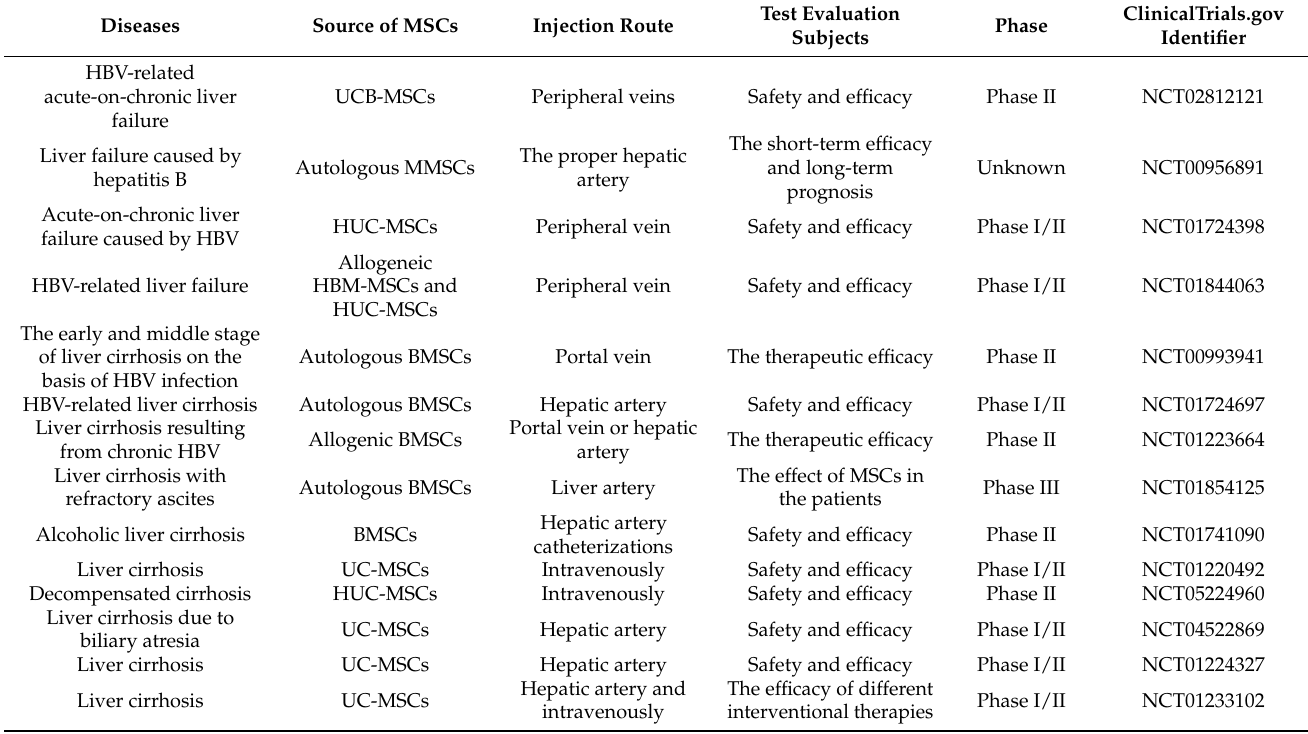
Table 1. Part of clinical studies related to MSCs for liver